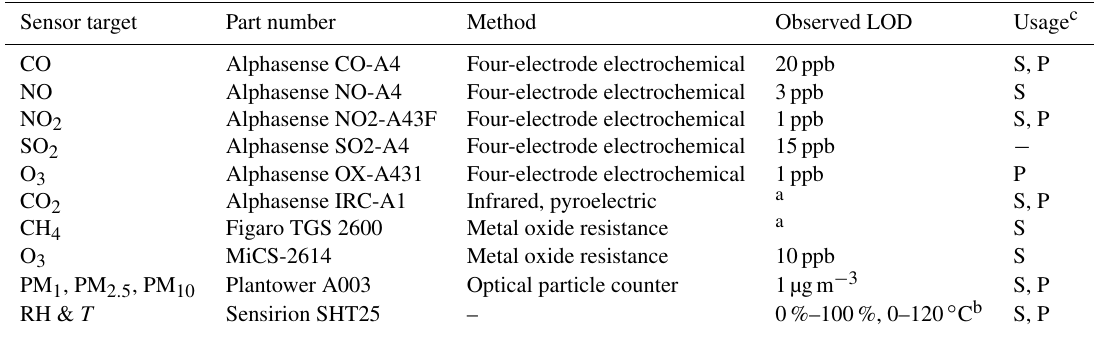
Table 1. Technical specifications concerning the pollutant and environmental sensors tested and